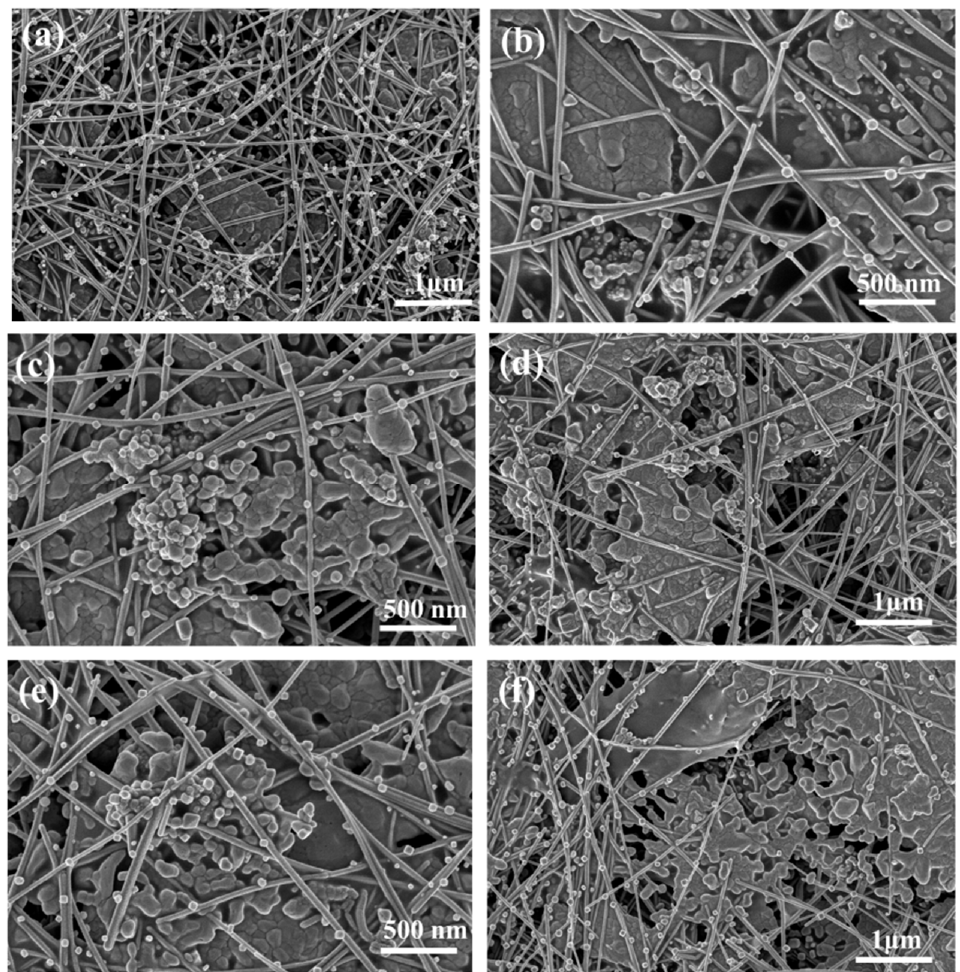
Figure 8. SEM images of silver paste paint film using WPU as the binder (sample F 20.0 P 2.5 W 7.5 ) at Table 7. Comparison of the ER of as-prepared composite silver pastes in this work with that of silver pastes in previous